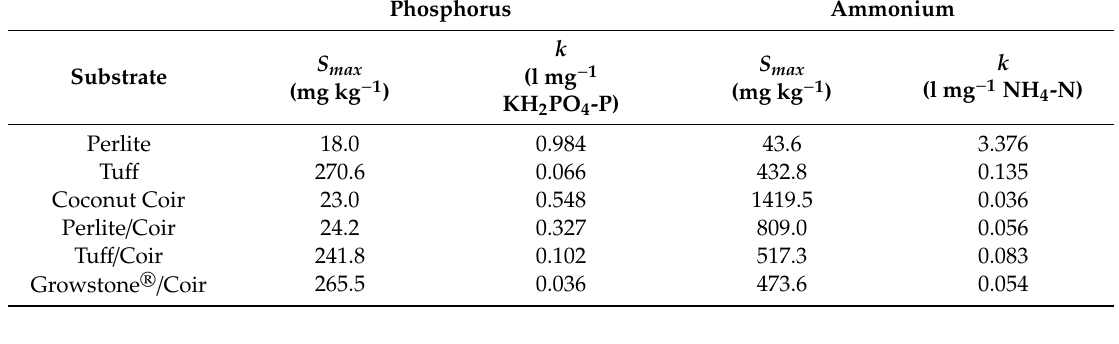
Table 5. Langmuir adsorption isotherm parameters for phosphorus and ammonium.